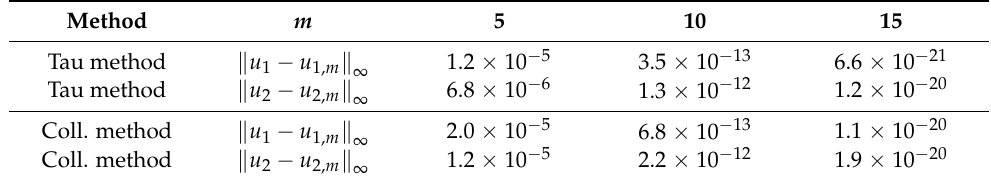
Figure 1. The absolute error, estimation of absolute error and the corrected absolute error to Example 1 for m = 6. Table 1. The maximum absolute errors on the interval [ 0,1 ] for different values of m for different m values and Example